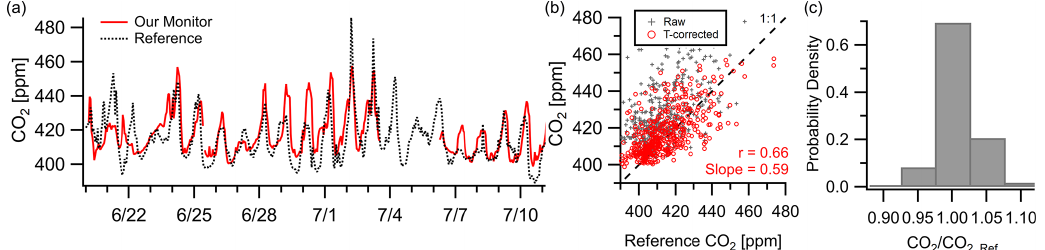
Figure 5. (a–b) Outdoor ambient monitor comparison of temperature-corrected CO 2 data from Baltimore, MD, with reference data. The monitor was located at the OWLETS campaign while the reference data came from the NIST NEB site (2.7km away). Occasional lags in pollution episodes, potentially due to the displacement of the monitor from the reference, are seen (e.g., 6 / 30, 7 / 1, 7 / 7), leading to a lower correlation coefficient than other pollutants. (c) Despite this, 70% of data points fall within 2.5% of the